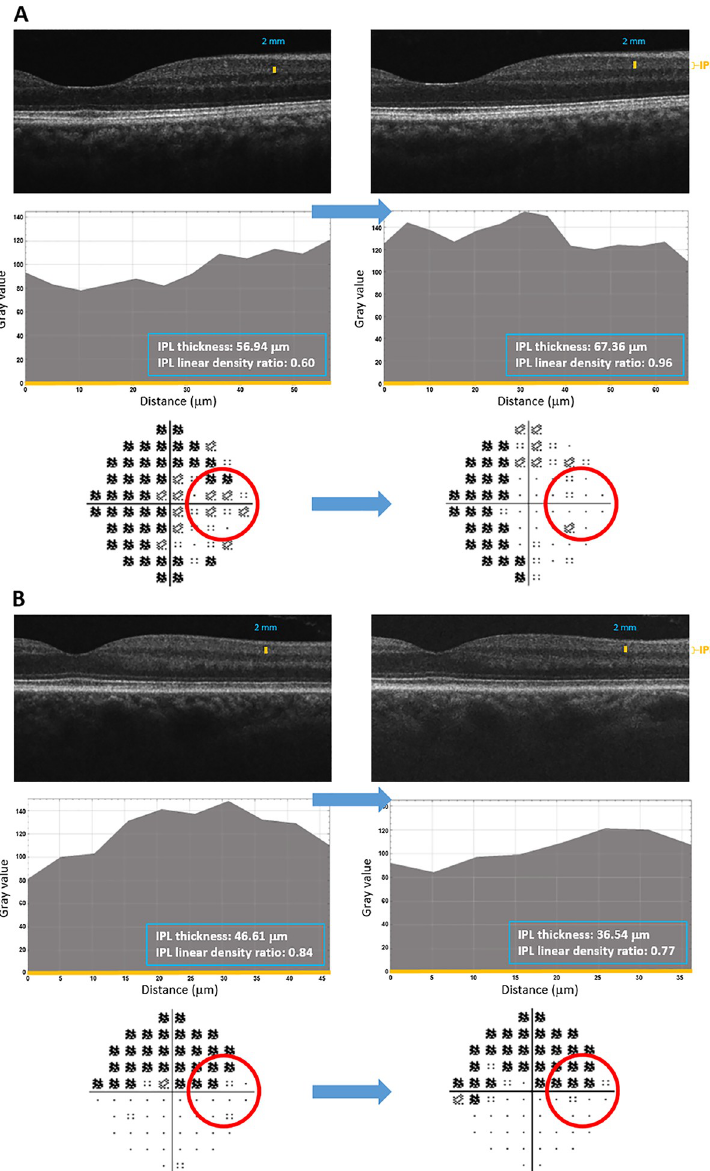
Fig 5. Sequential analysis of macular SD-OCT scans and 10–2 visual fields in patients with glaucoma. A. Temporal visual field points (red circle) corresponding to increased thickness (and density) of the IPL showed improvement. B. Temporal visual field points (red circle) corresponding to decreased thickness (and density) of the IPL showed worsening. The top rows in each panel show sequential macular SD-OCT scans. Middle rows in each panel show linear densitometry graphs obtained from the nasal side at 2 mm distance from the macula center. Bottom rows in each panel show 10–2 total deviation plots. The mean value of reflectance intensities that reflects the grayscale level within the area under the curve (grayscale intensity value/ μ m 2 ) was then normalized to minimize imaging variability in sequentially obtained scans (as described in our methodology). The numbers given in the blue box are the average IPL thickness and the average IPL intensity ratio calculated after normalization. The position where these data were obtained is marked with the yellow bar on SD-OCT scans. The thickness of the IPL corresponds to the X axis of the histograms (also shown in yellow color). Note that the localized alterations of IPL, such as decreased thickness (and density), were in correlation with progressing visual field defects at corresponding locations, most of which were clustered.